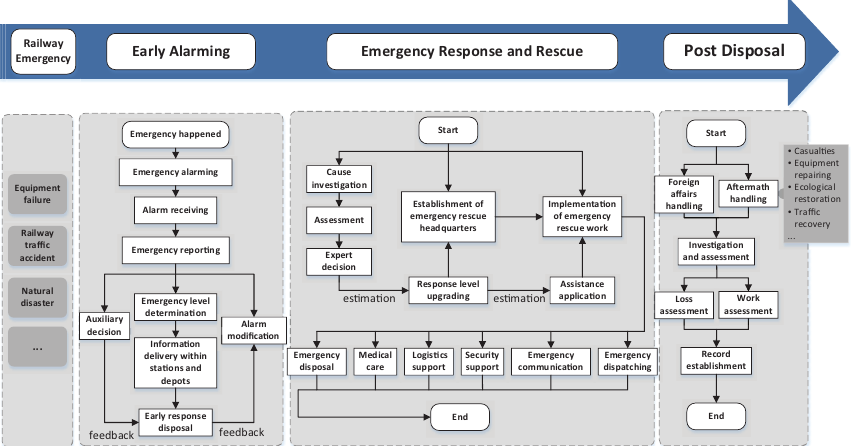
Figure 1. The process of the general